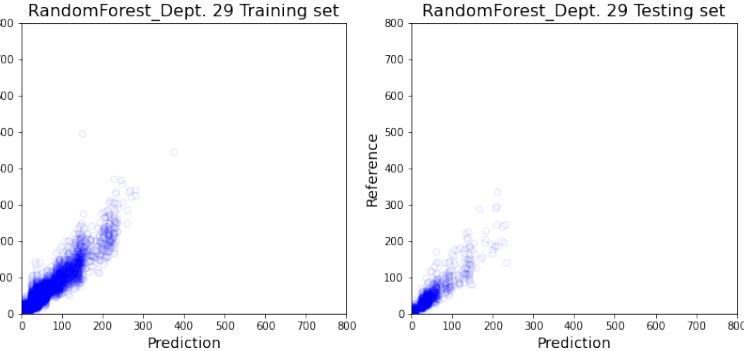
Figure A2. Model Performance of RandomForest on Dept.29. The visualization of training and testing data for department specific model on department 29 with Random Forest.